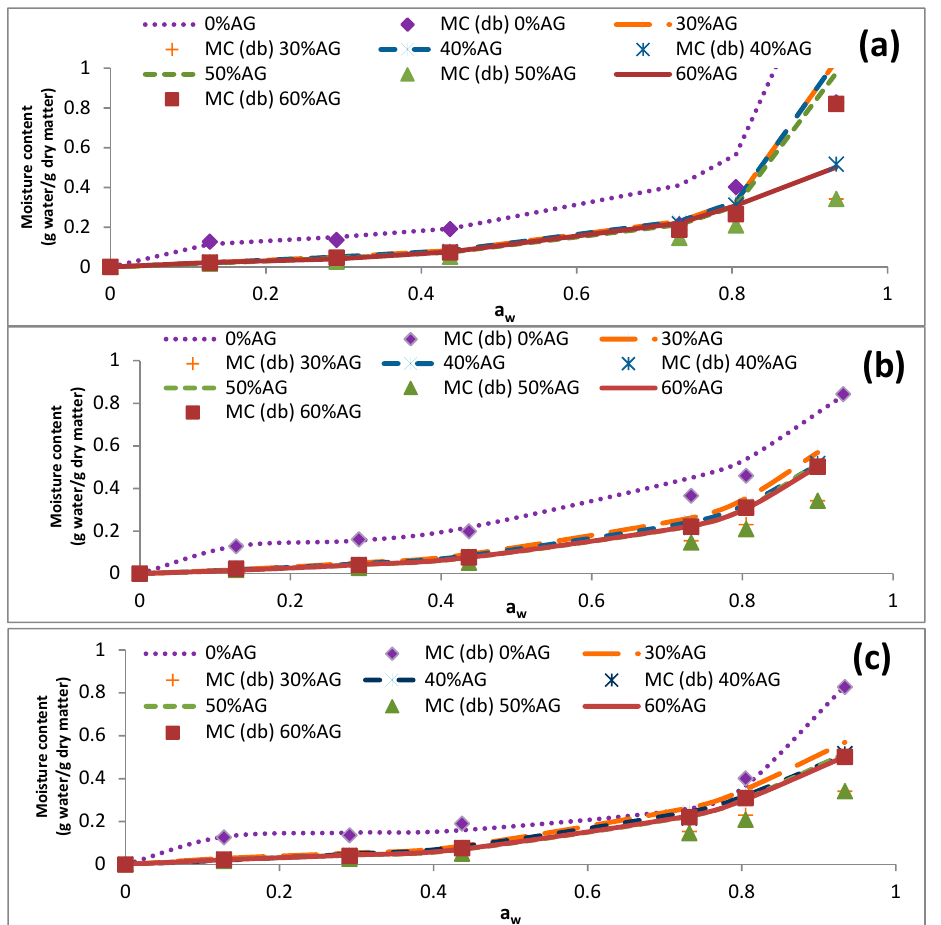
Figure 1. E ff ects of acacia gum concentration on the equilibrium moisture sorption isotherm of date syrup powders at 5 ◦ C. The experimental data are presented as symbols and the data obtained by fitting the experimental data into mathematical models are presented as lines. ( a – c ) represent the obtained data from BET, GAB, and Peleg models. 0% AG: 100% DS-0% AG; 30% AG: 70% DS-30% AG; 40% AG: 60% DS-40% acacia gum; 50% AG: 50% DS-50% AG; 60% AG: 40% DS-60% acacia gum; DS: date syrup; AG: acacia